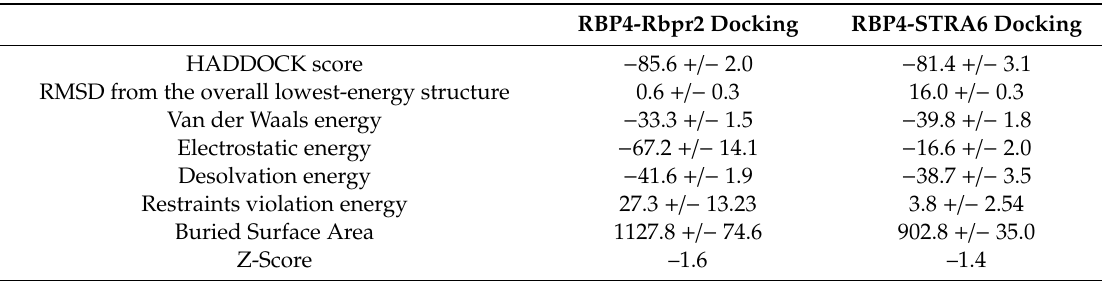
Table 1. Parameters obtained using the online docking server HADDOCK for RBP4-Rbpr2 and RBP4-STRA6